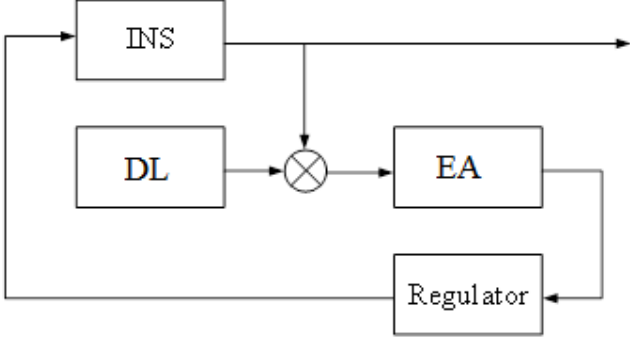
Figure 2. Scheme of connection to the INS estimation algorithm and regulator.